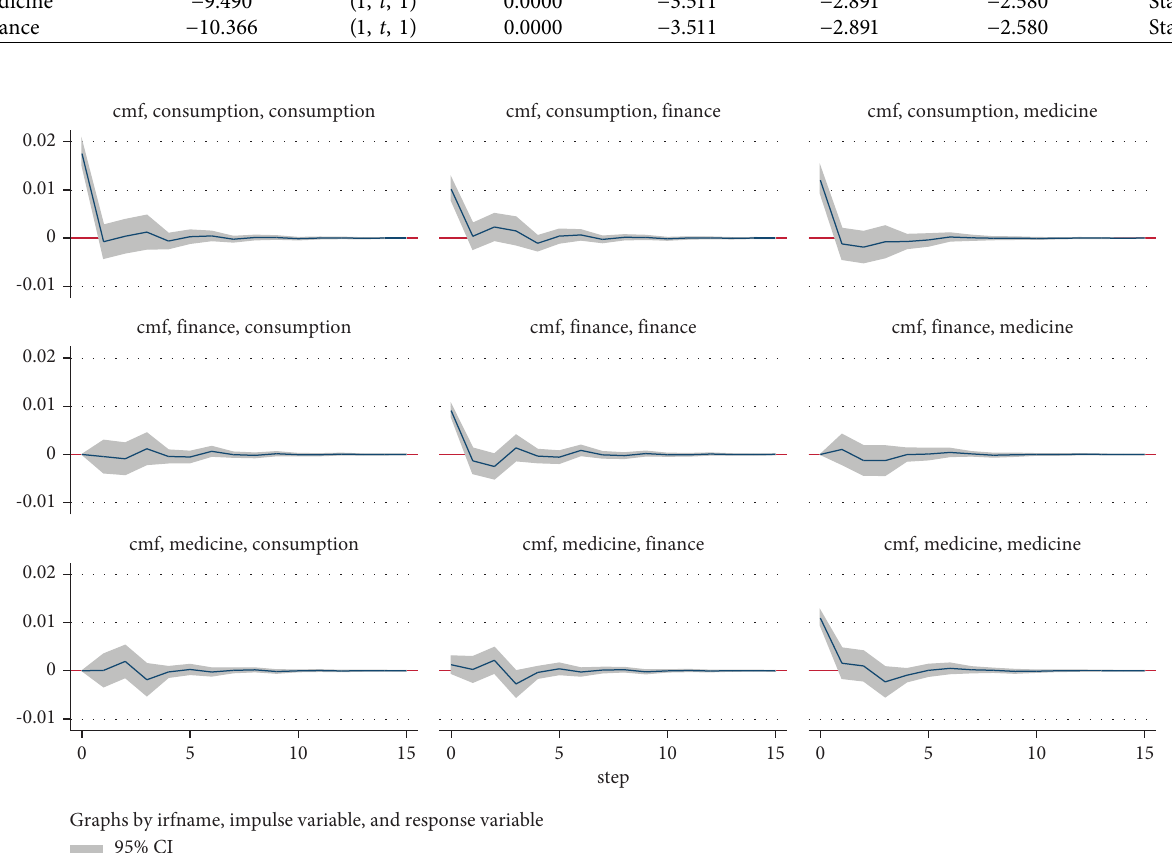
Figure 7: Impulse response diagrams of the consumption industry, the pharmaceutical industry, and the fnancial